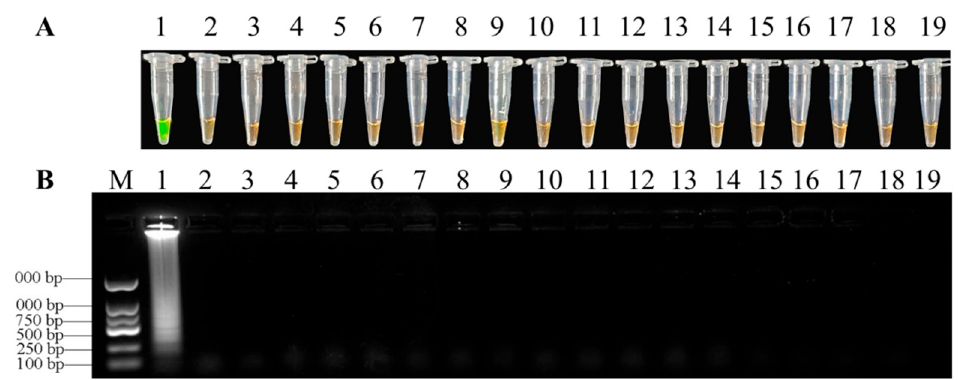
Figure 5. Specificity of LAMP detection of F. oxysporum . ( A ) = Assessment based on SYBR Green I visualization of color change; ( B ) = LAMP products analyzed by agarose gel electrophoresis. 1,